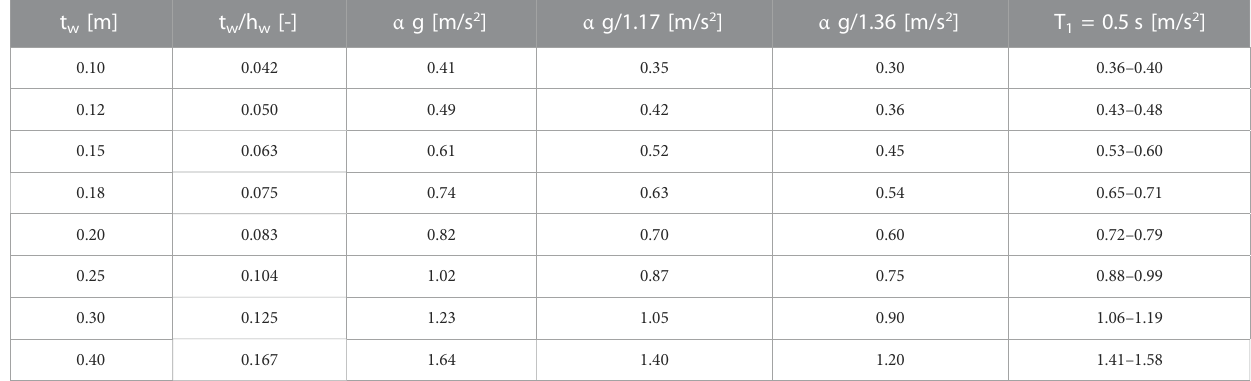
TABLE 8 Results for a wall height of 2.4 m located in the upper fl oors in case of soil class C and a period of the primary structure of T 1 = 0.5 s. The considered ultimate ground accelerations for damping ratio between 3% and 5% (last column) compare well with the reduced static stability